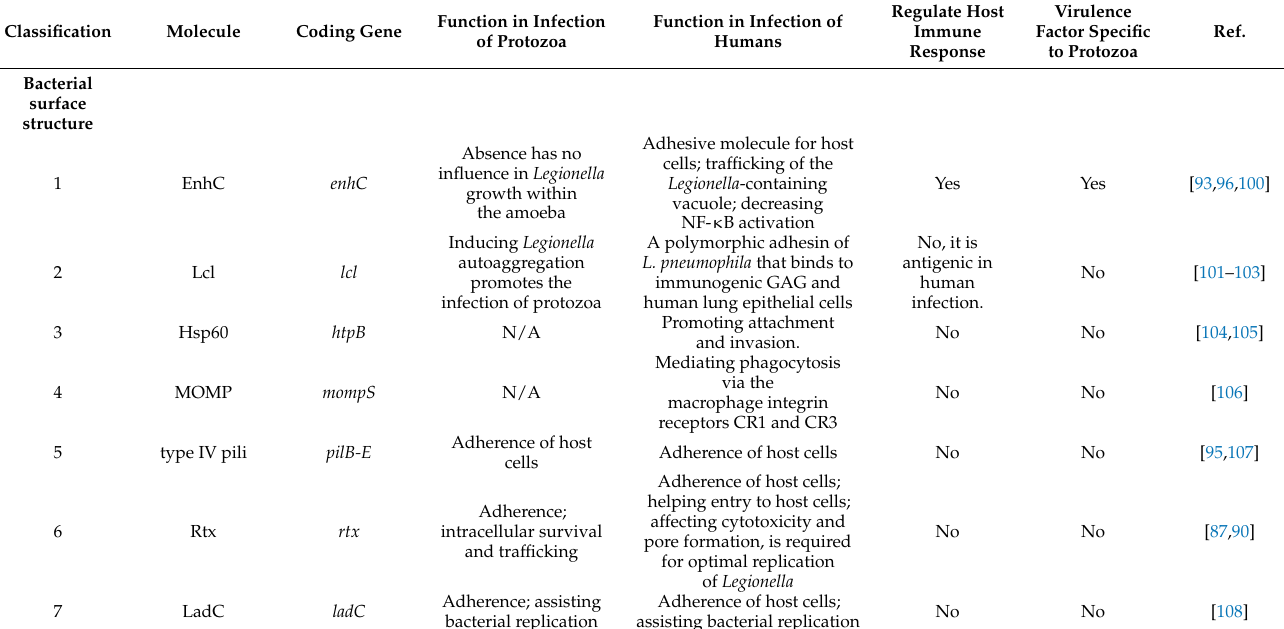
Table 1. Legionella molecules participate in the infection of protozoans and